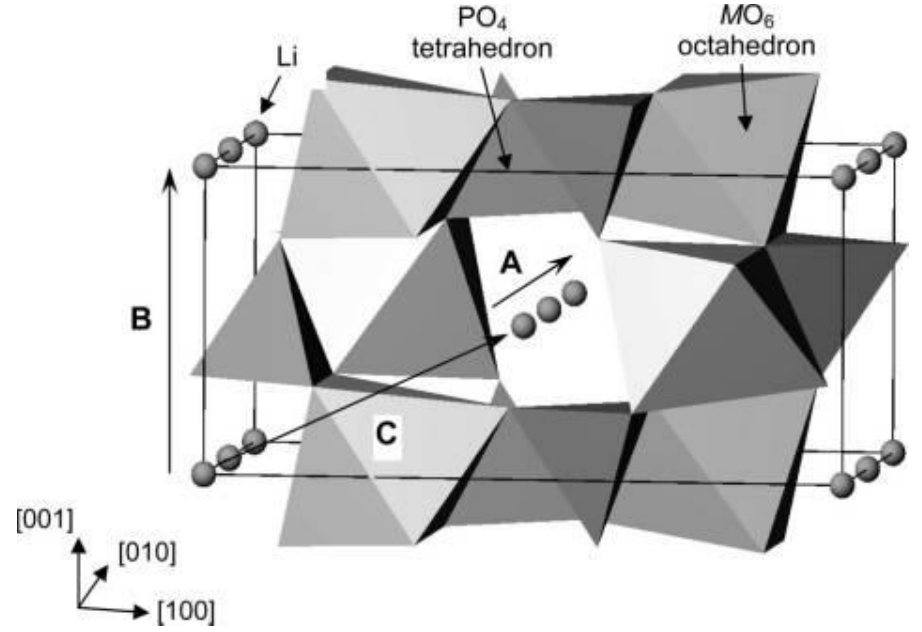
Figure 7. Paths considered for Li + migration in olivine-structured phosphates LiMPO 4 (M = Mn, Fe, Co, and Ni). Reprinted with permission from Ref. [52]. Copyright 2008 American Chemical